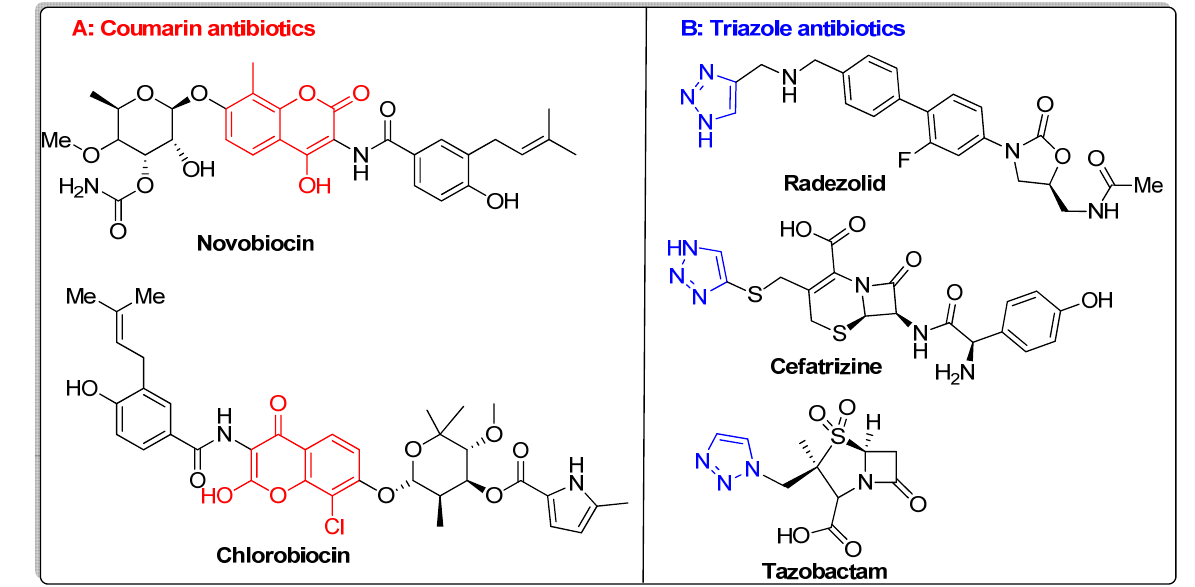
Figure 1. Clinically used important ( A ) coumarin and ( B ) triazole-based antibiotic drugs.